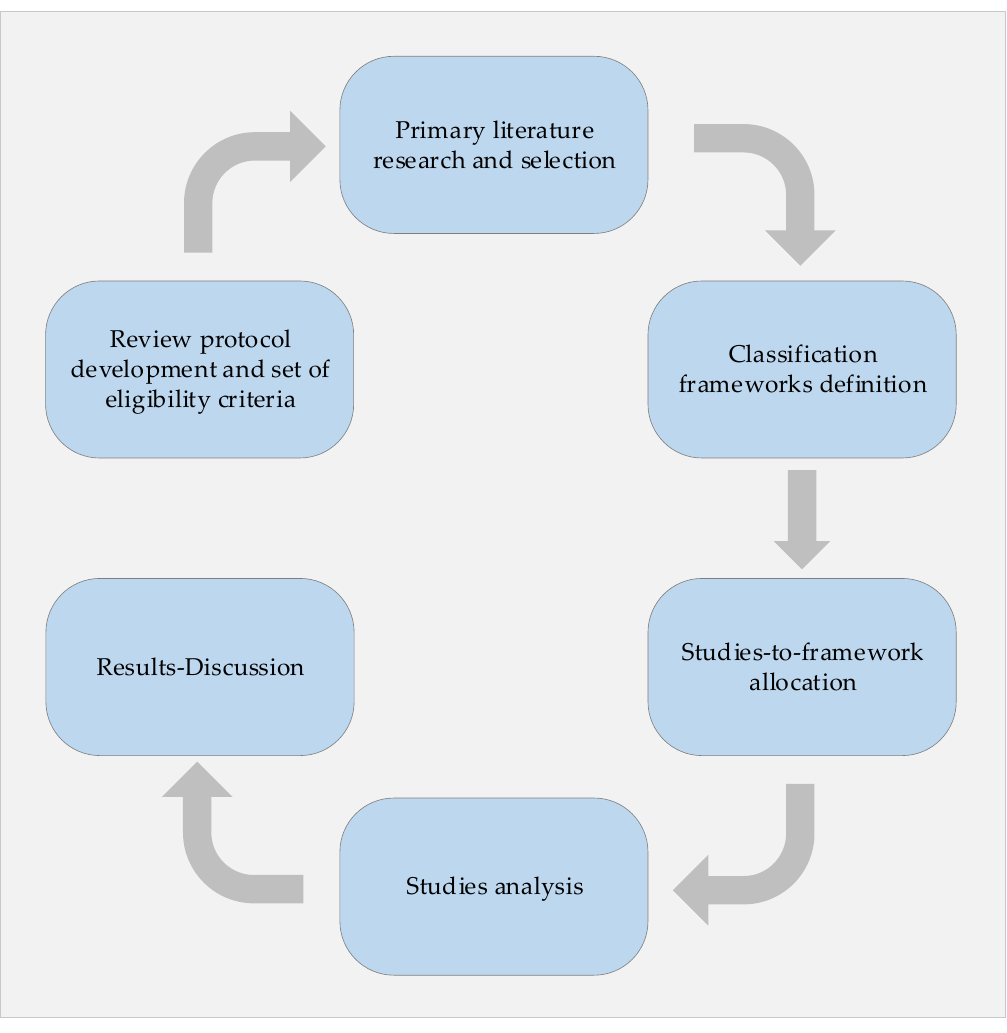
Figure 1. The summary of the review process.